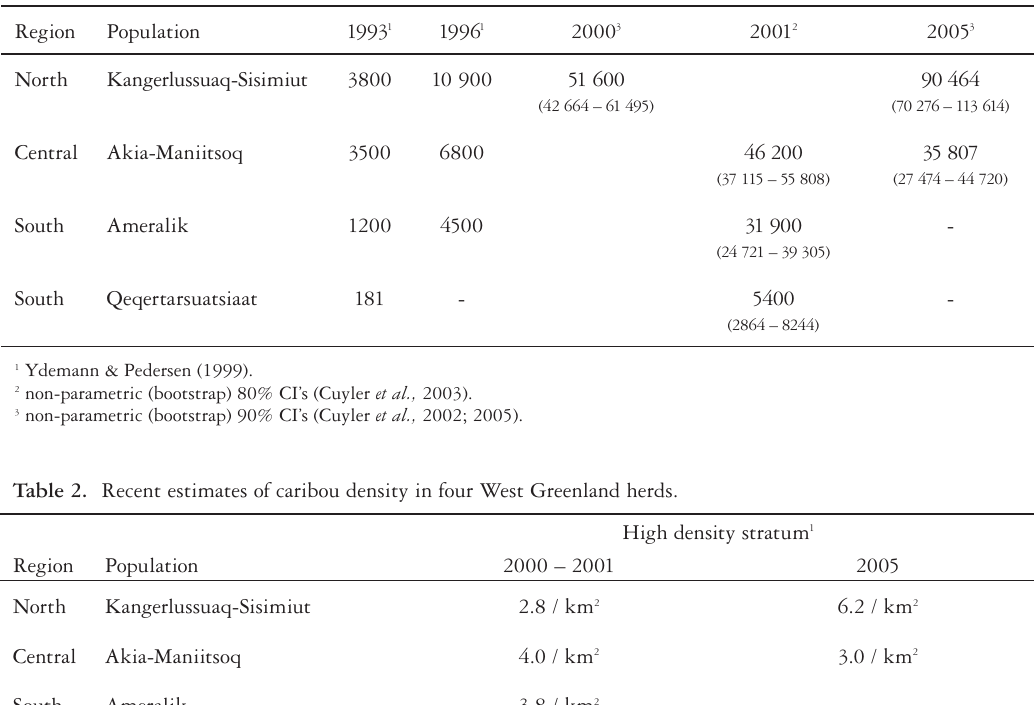
Table 1. Recent pre-calving estimates of caribou abundance in four West Greenland herds.